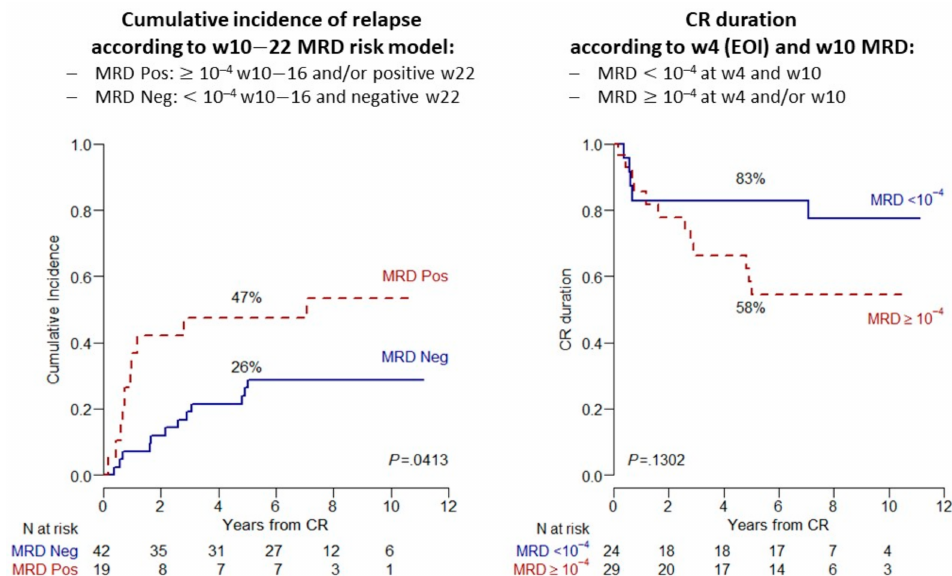
Figure 3. MRD-related incidence of relapse and duration of CR from NILG trial 10/07 in 61 AYA patients aged 10–40 years with Ph − ALL: ( Left ) cumulative incidence of relapse; and ( Right ) com- parative CR duration in subsets with MRD < 0.01%/10 − 4 at EOI/Week 4 and Week 10 vs. others (non-significant p value due to small patient